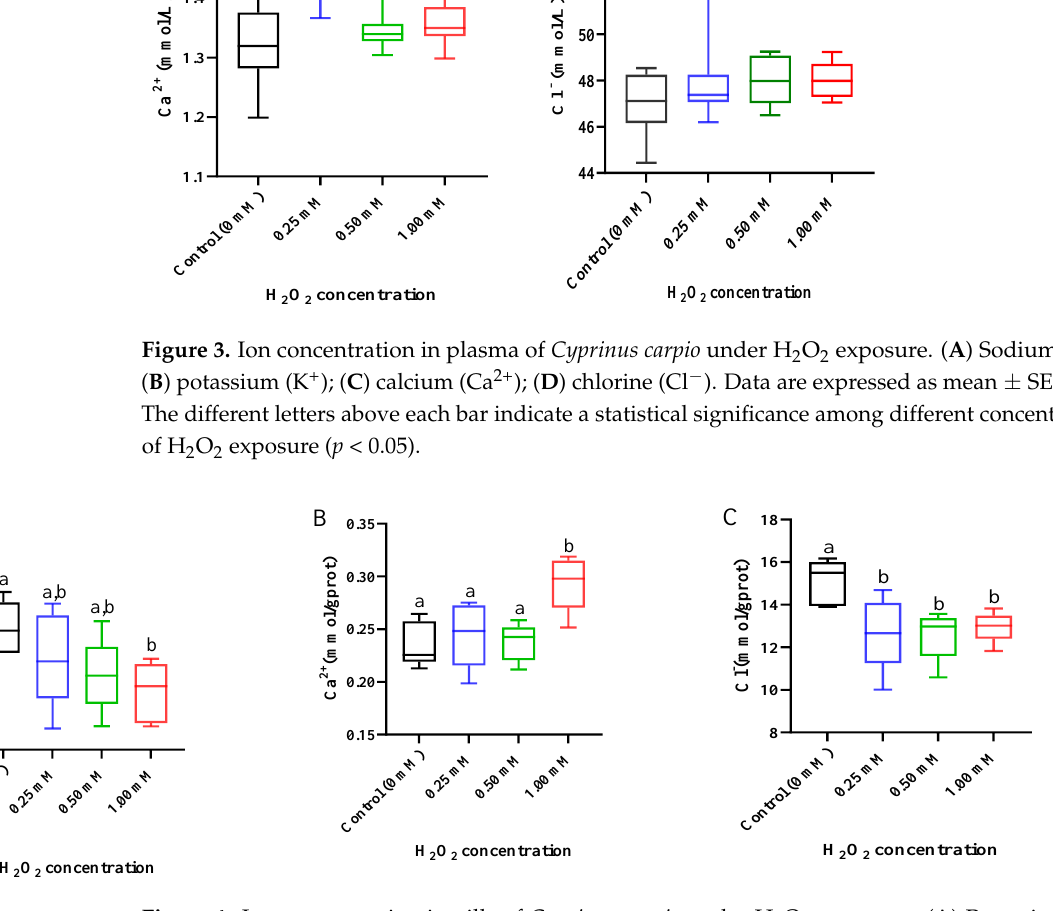
Figure 4. Ion concentration in gills of Cyprinus carpio under H 2 O 2 exposure. ( A ) Potassium (K + ); ( B ) calcium (Ca 2+ ); ( C ) chlorine (Cl − ). Data are expressed as mean ± SE (n = 9). The different letters above each bar indicate a statistical significance among different concentrations of H 2 O 2 exposure ( p < 0.05).